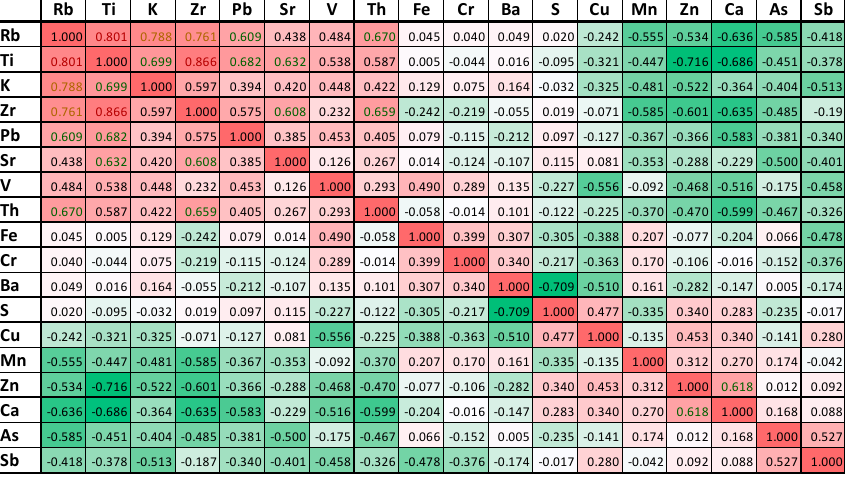
Figure 8. Pearson correlations on clr data for Group Ah, pXRF measurements (as heat map). The use of colour shading and its interpretation is described in [35].